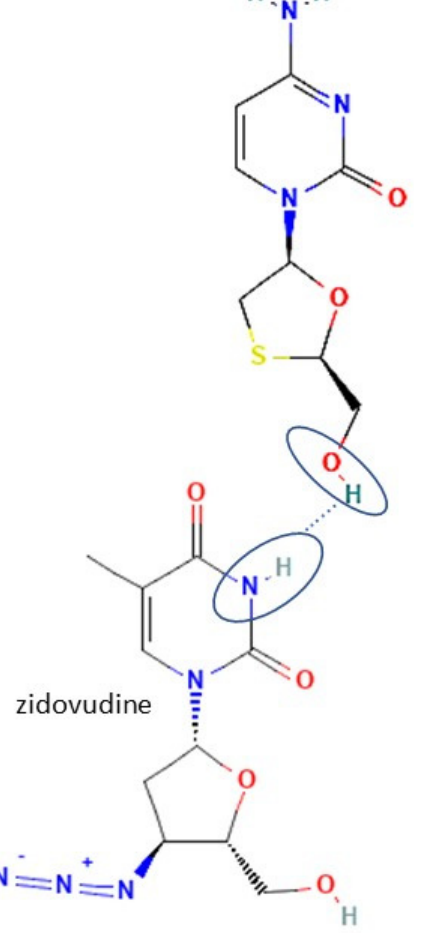
Figure 1. Multicomponent system antiviral lamivudine-zidovudine for HIV.